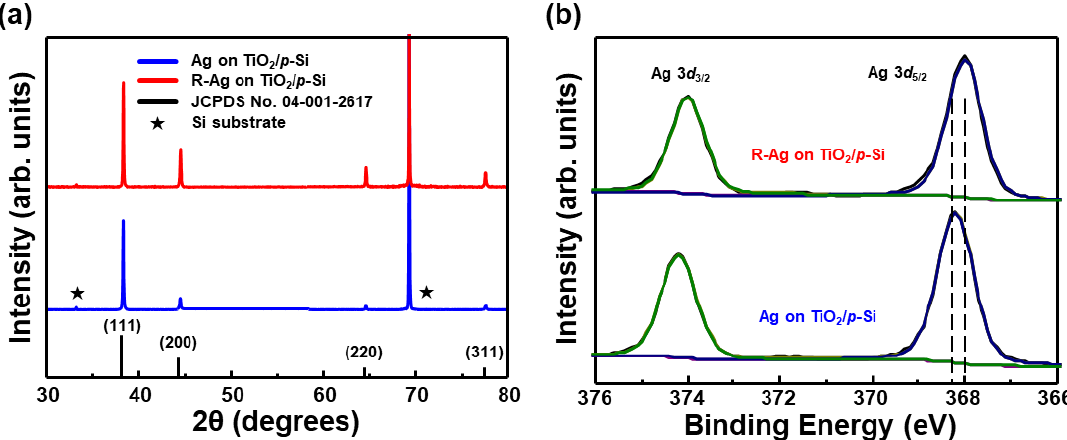
Figure 2. Characterization of Ag and R-Ag catalysts on TiO 2 / p -Si photocathodes. ( a ) XRD patterns and ( b ) XPS spectrum of the Ag catalysts (blue) and R-Ag catalysts (red) on TiO 2 / p -Si photocathode.